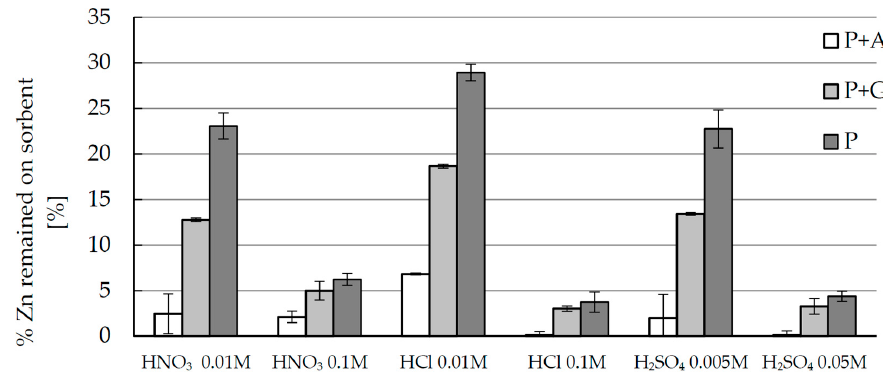
Figure 4. Comparison of zinc(II) ions desorption from pectin-based biosorbents (P + A—hybrid pectin biosorbent with agar, P + G—hybrid pectin biosorbent with guar gum, P—sole pectin biosorbent) using various acid solutions of various concentration. Mass of sorbent 0.03 g, volume of solution: 0.01 L, pH = 6, temperature 22 ± 1 °C, time of contact 24 h.